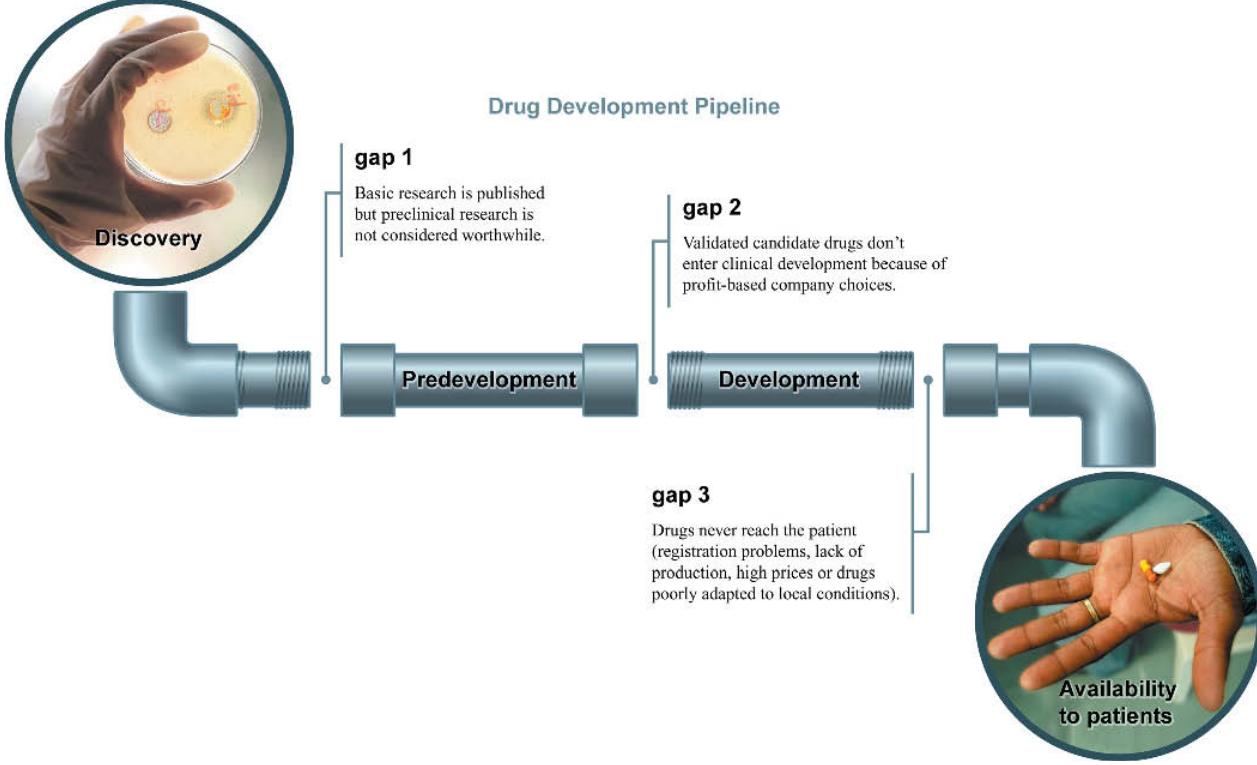
Figure 1. The Drug Development Pipeline Because of the gaps in the development pipeline, potential new drugs for neglected diseases often stay stuck at an early stage